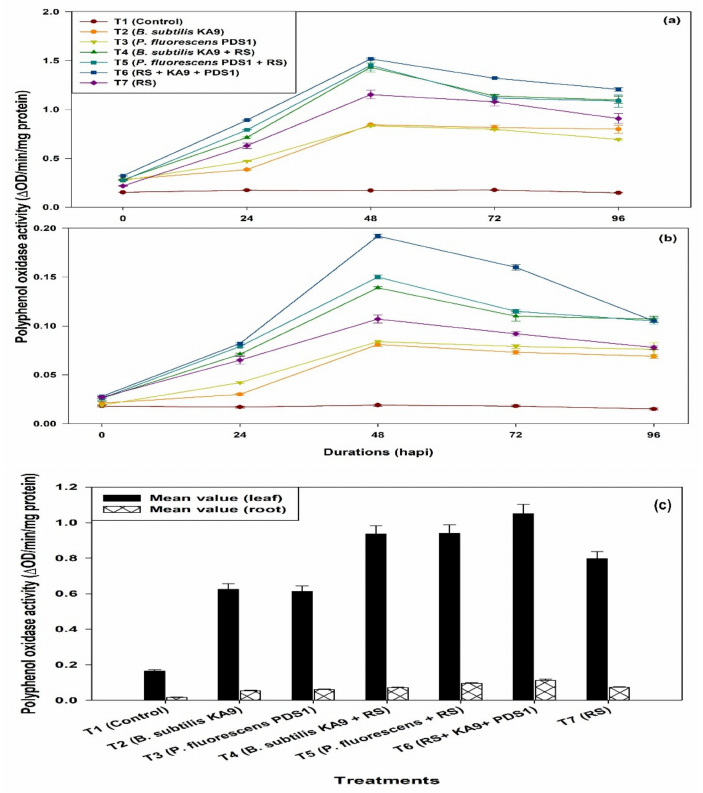
Figure 11. ( a ) The effect of biocontrol agents on the induction of polyphenyl oxidase activities in chilli leaves against R. solanacearum in glasshouse conditions; observations were recorded after 30 days of sowing. ( b ) The effect of biocontrol agents on the induction of polyphenyl oxidase activities in chilli roots against R. solanacearum in glasshouse conditions; observations were recorded after 30 days of sowing. The results are expressed as average of three replications and error bars indicate standard deviation of the means. ( c ) Mean value comparison of the induction of Polyphenol oxidase activities in between chilli leaves and root tissue against Ralstonia solanacearum in glasshouse condition after 30 days of sowing. The results are expressed as average of three replications and error bars indicate standard deviation of the